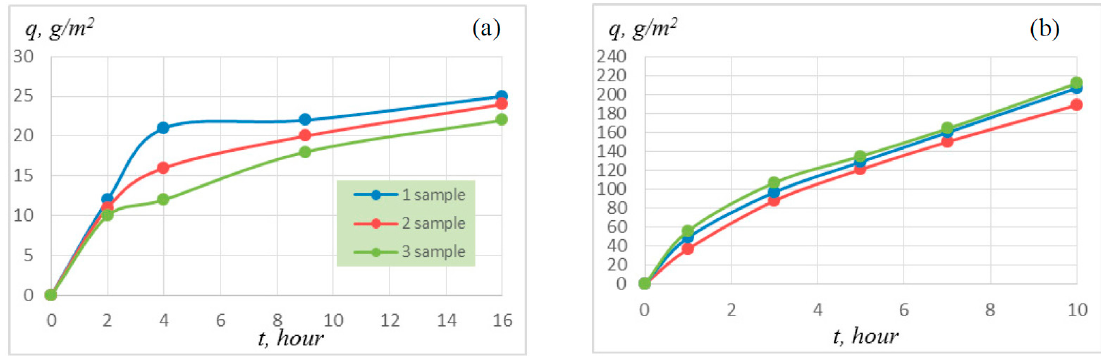
Figure 5. Specific sample mass increment at ( a ) 900 °C and ( b ) 1100 °C.